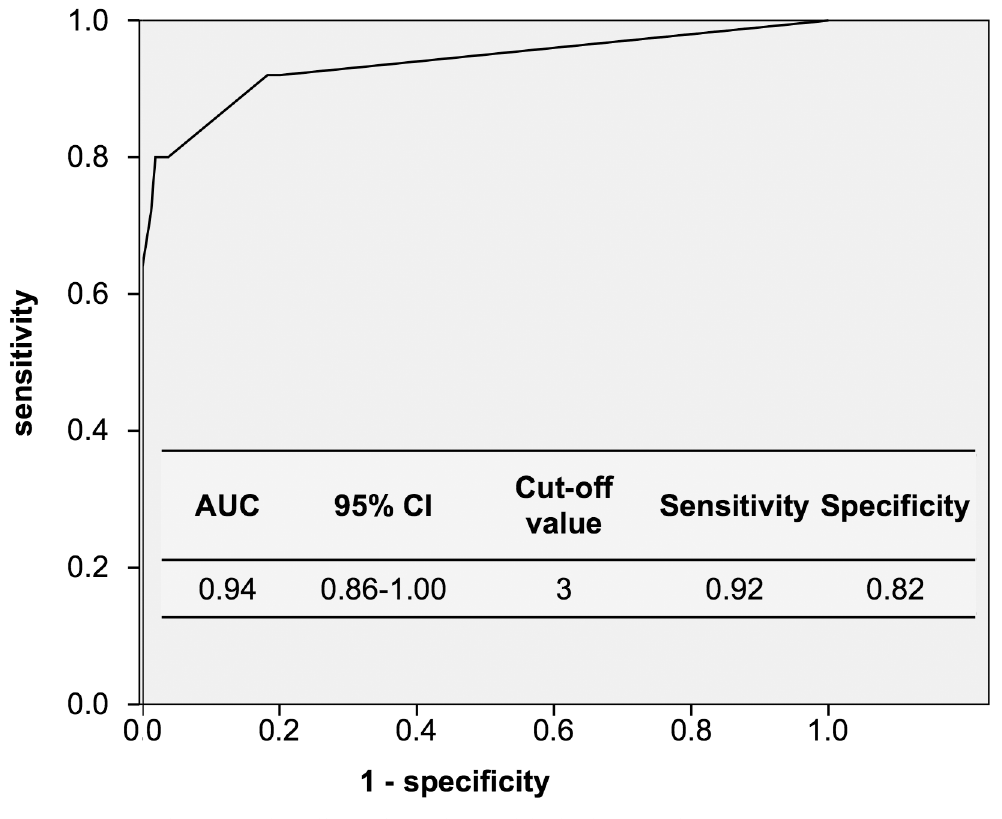
Fig 2. ROC curve of PDVFS and cutoff point for prediction of the development of aspiration